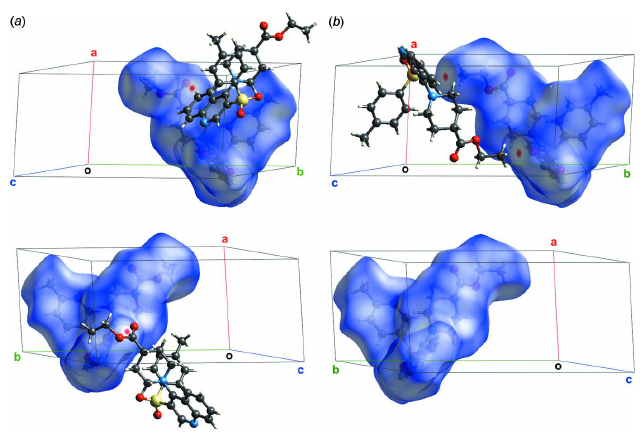
Figure 3 Distribution of the value d norm onto the Hirshfeld surfaces of the conformers A ( a ) and B ( b ).